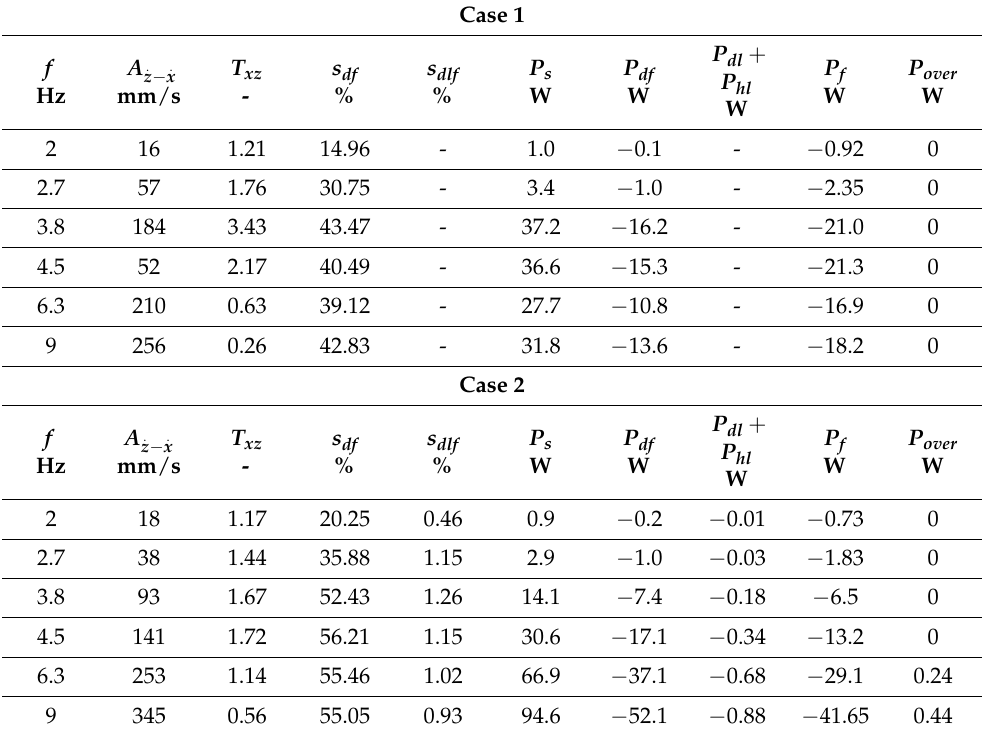
Table 3. Factors of RVR-MRD system operation at various